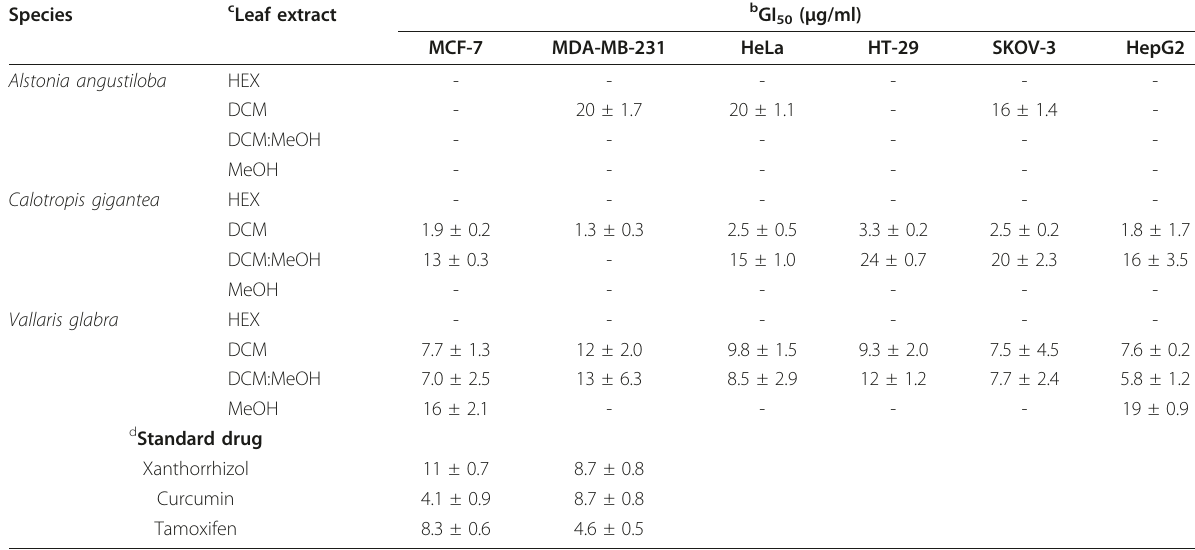
Table 1 Antiproliferative activity of leaf extracts of three Apocynaceae species against six human cancer cell lines a